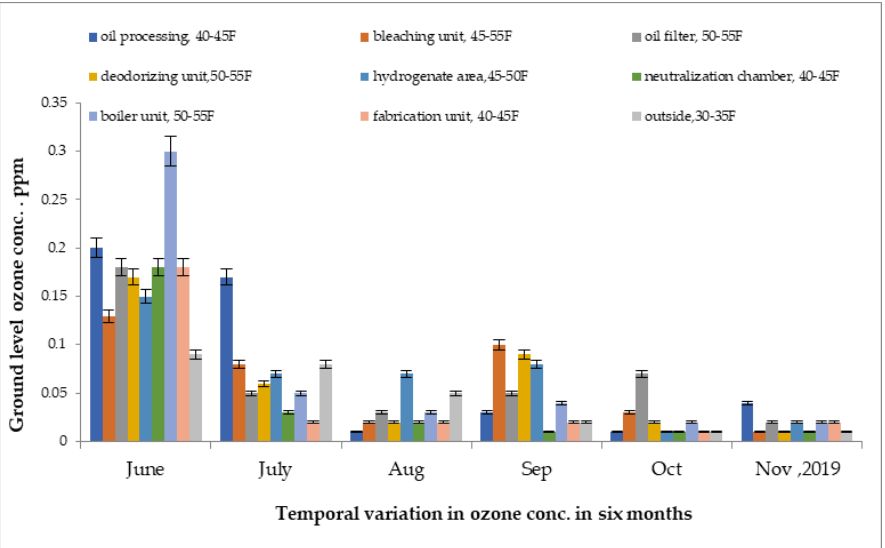
Figure 7. Variation of ground-level ozone concentration in different units of oil industry from June 2019 to November 2019. 2019 to November 2019.